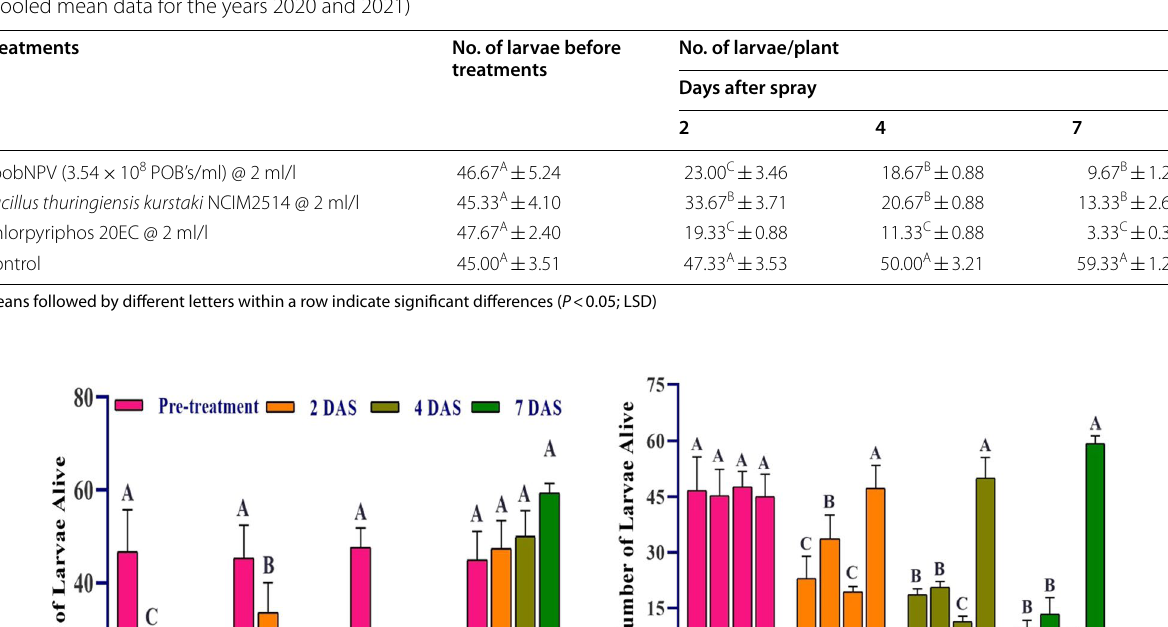
(pooled mean data for the years 2020 and 2021) Treatments